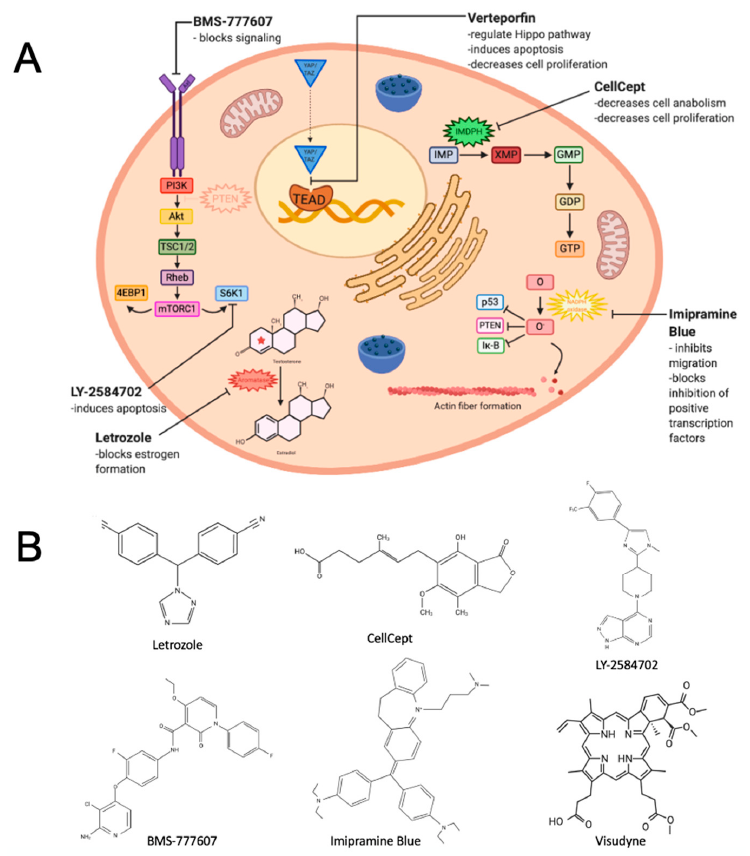
Figure 1. Panel ( A ): Mechanisms of drug inhibition on cellular pathways. (Letrozole). Aromatase catalyzes the conversion of androgens to estrogens by aromatization of the A-ring. A-ring structure of androgens is noted by the red star. (CellCept) GTP synthesis increases cell anabolism through upregulation of inosine monophosphate dehydrogenase, IMPDH, the rate-limiting enzyme of the GTP nucleotide synthesis pathway [31,32]. IMPDH is inhibited by CellCept. (BMS-777607 and LY-2584702) Shown is the canonical oncogenic kinase signaling pathway downstream of TAM receptor, Axl. PTEN deficiency is depicted by transparency. (Imipramine Blue) Imipramine Blue, shown here in schematic, is thought to have an effect on cell migration due to its ability to inhibit NADPH oxidase, which catalyzes electron transfer to oxygen from NADPH, thereby limiting actin fiber formation. Importantly, O 2 − inhibits transcription factors critical to cell survival, including PTEN, I κ -B, p53 [33]. (Verteporfin) Verteporfin can act as an inhibitor of the Yes-associated protein (YAP) and PDZ-binding motif (TAZ) family transcriptional coactivators [34], which have roles in the Hippo and RTK signaling pathways. Verteporfin disrupts the interaction between YAP and TEAD transcription factors, which regulate the Hippo signaling pathway. Panel ( B ): Chemical structure of the molecules discussed